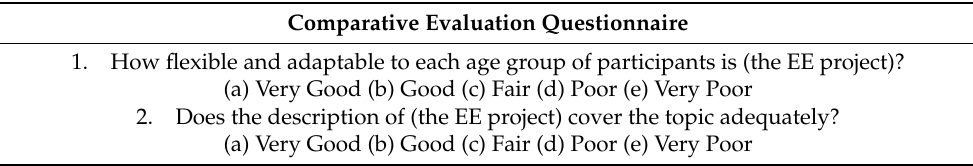
Table 1. The questionnaire for comparative evaluation